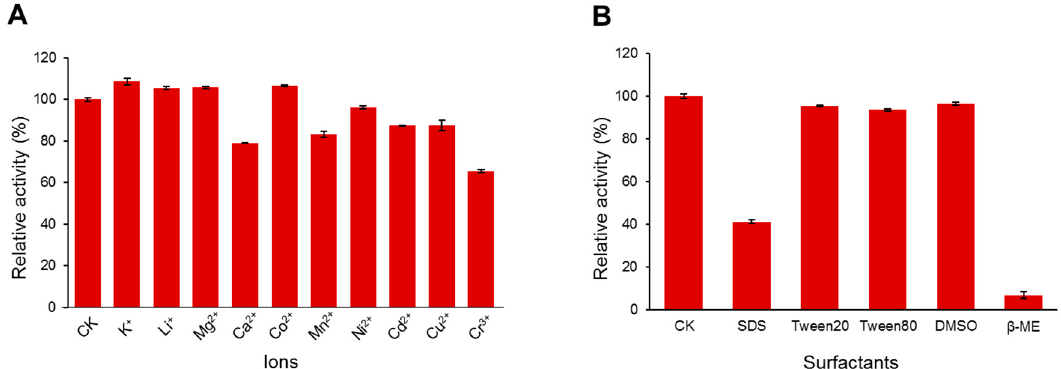
Figure 5. Effects of inorganic ions and chemicals on keratinolytic activity of DgoKerA. ( A ) Effects of various metal ions on keratinase activity; ( B ) effects of chemicals on keratinase activity. Each value was repeated in triple independent